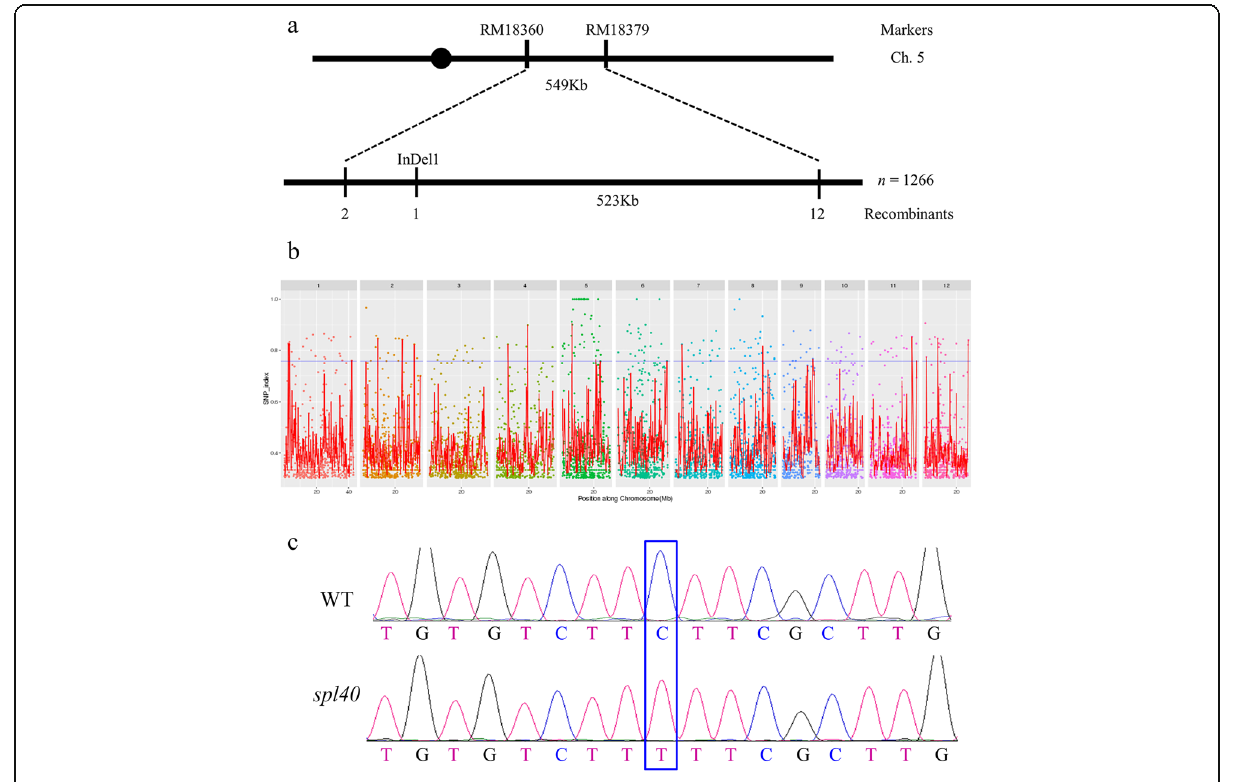
Fig. 6 MutMap assisted mapping of spl40 gene on the long arm of chromosome 5. a Fine mapping of the candidate region of spl40 . b Manhattan plot depicting the distribution of SNPs along 12 rice chromosomes. c Confirmation of the spl40 mutation by